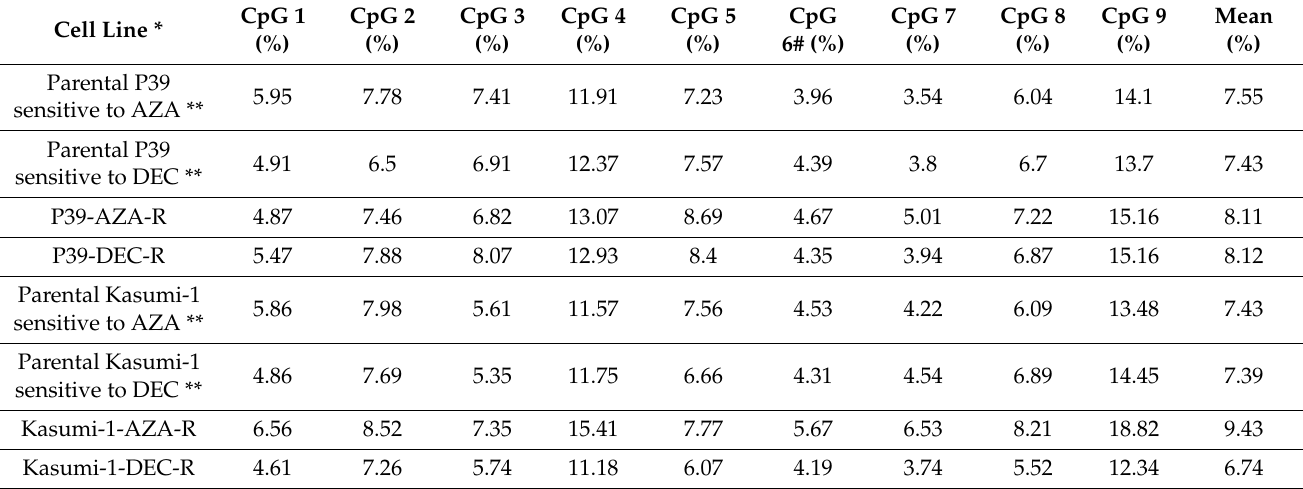
Table 1. PTEN methylation of cell lines sensitive to and resistant to hypomethylating